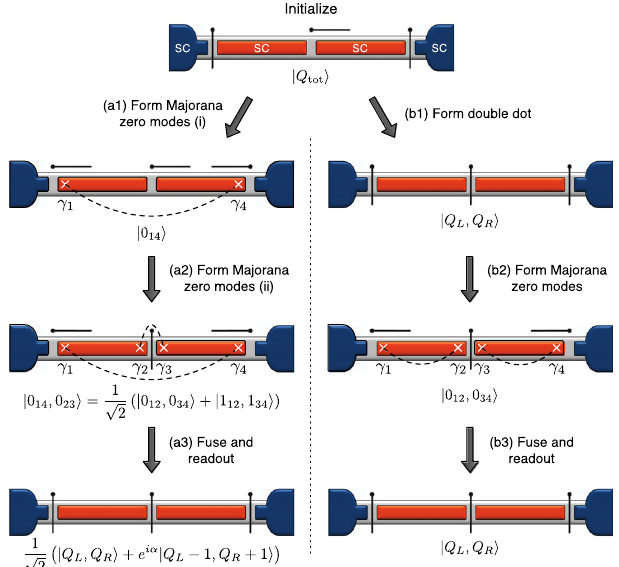
FIG. 6. Protocol to detect the Ising-anyon fusion rule σ × σ ¼ I þ ψ via charge sensing. The device contains two superconduct- ing islands (red) Josephson coupled to outer trivial bulk super- conductors (blue); intervening gate-tunable valves control the Josephson-to-charging-energy ratios. The system is initialized into a unique ground state by opening the middle valve while closing the outer valves. In the control experiment (right path), the middle valve closes before opening the outer valves, thus nucleating out of the vacuum two pairs of Ising anyons binding Majorana modes γ 1 and γ 3 , as indicated by dashed lines. ; 2 ; 4 Reclosing the outer valves fuses these same pairs back into the vacuum, corresponding to the I fusion channel. Charge read out on the islands is correspondingly deterministic. Instead, closing the middle valve after opening the outer valves (left path) first nucleates Ising anyons binding γ 1 and later γ 2 . Closing the ; 4 ; 3 outer valves now fuses the anyons in a nontrivial way that accesses both the I and ψ fusion channels. This leads to an equal- amplitude superposition of states in the measurement basis and thus probabilistic charge read